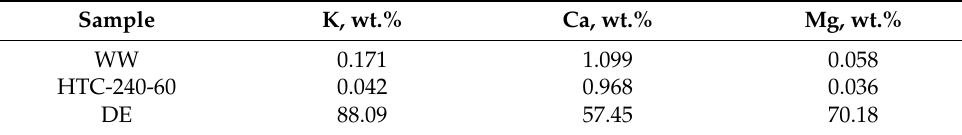
Table 4. Alkali metal analysis of WW and